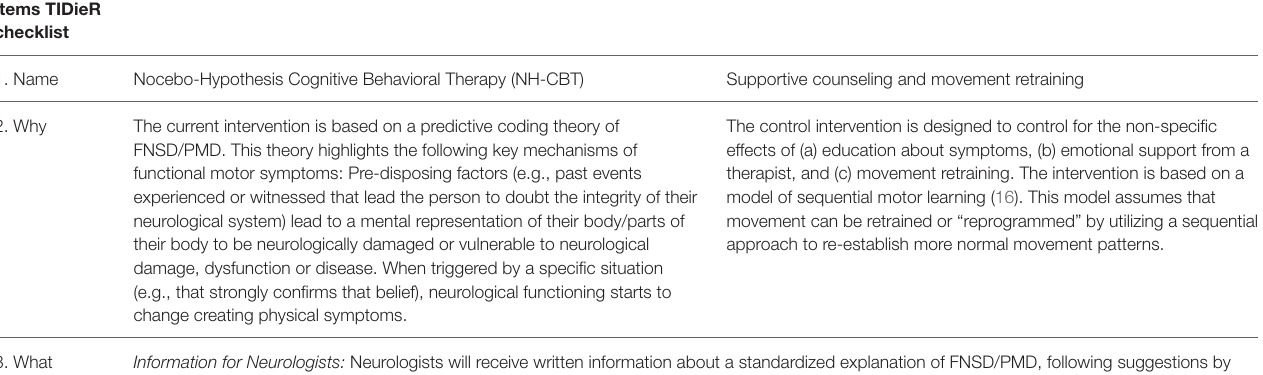
TABLE 1 | Nocebo-Hypothesis Cognitive Behavioral Therapy and supportive counseling and movement retraining (active control intervention) described following the TIDieR checklist. Items TIDieR